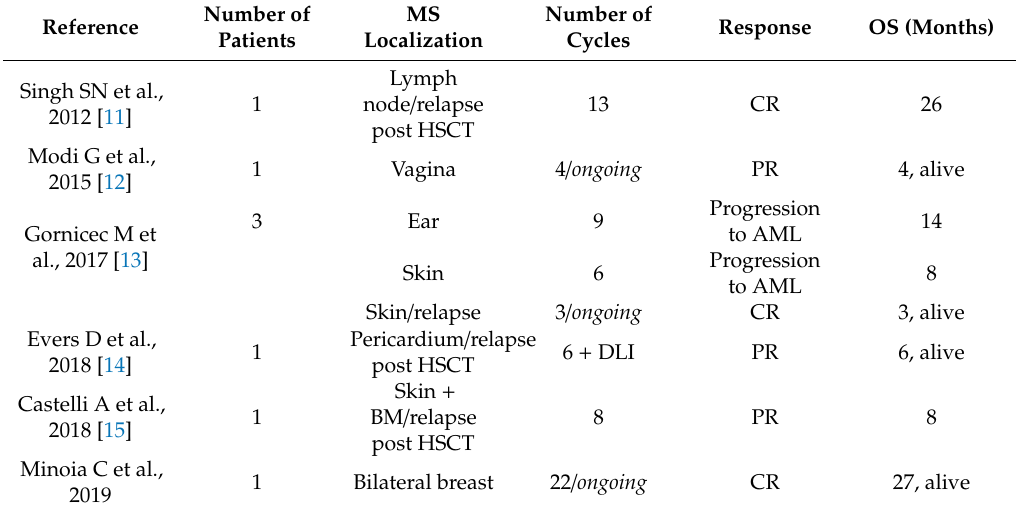
Table 1. Reports of patients treated with decitabine for